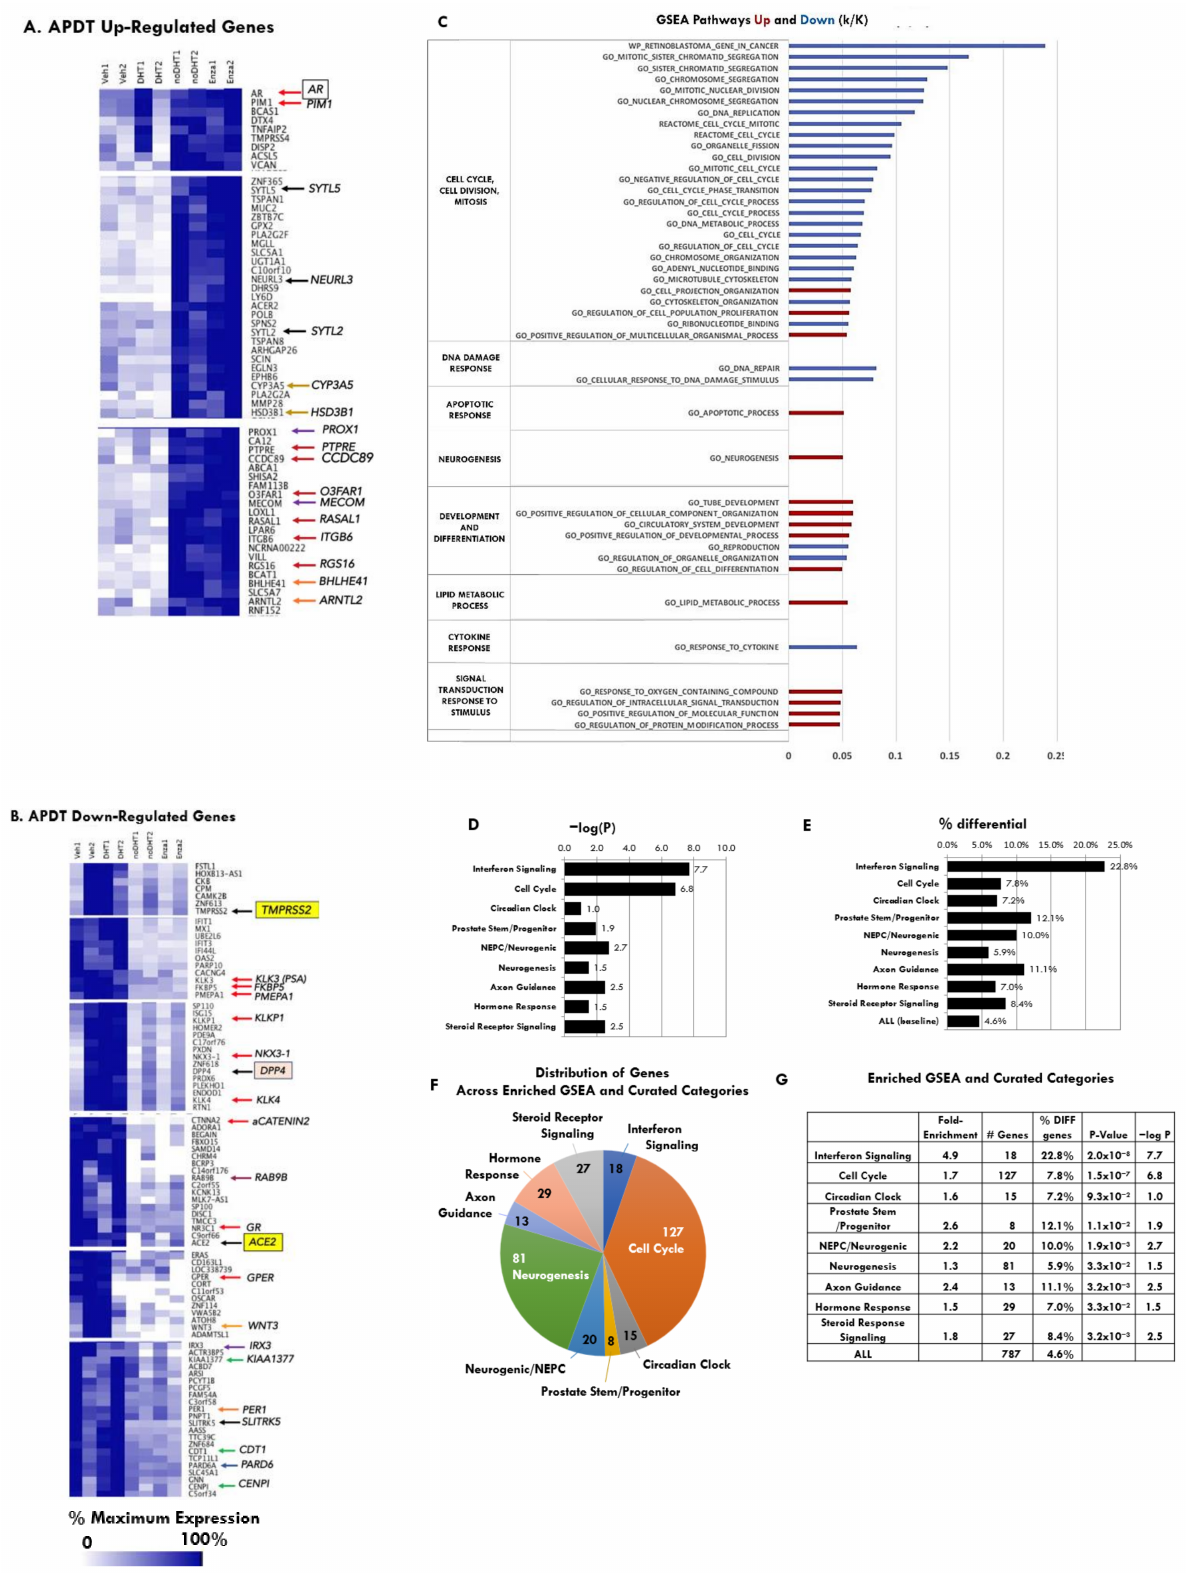
Figure 2. Gene expression profiling of APDT treated patient xenograft-derived organoids (PDOs) and gene set enrichment analysis (GSEA) of APDT up-regulated and down-regulated pathways in PDOs. ( A ) APDT significantly up-regulated genes, ( B ) APDT significantly down-regulated